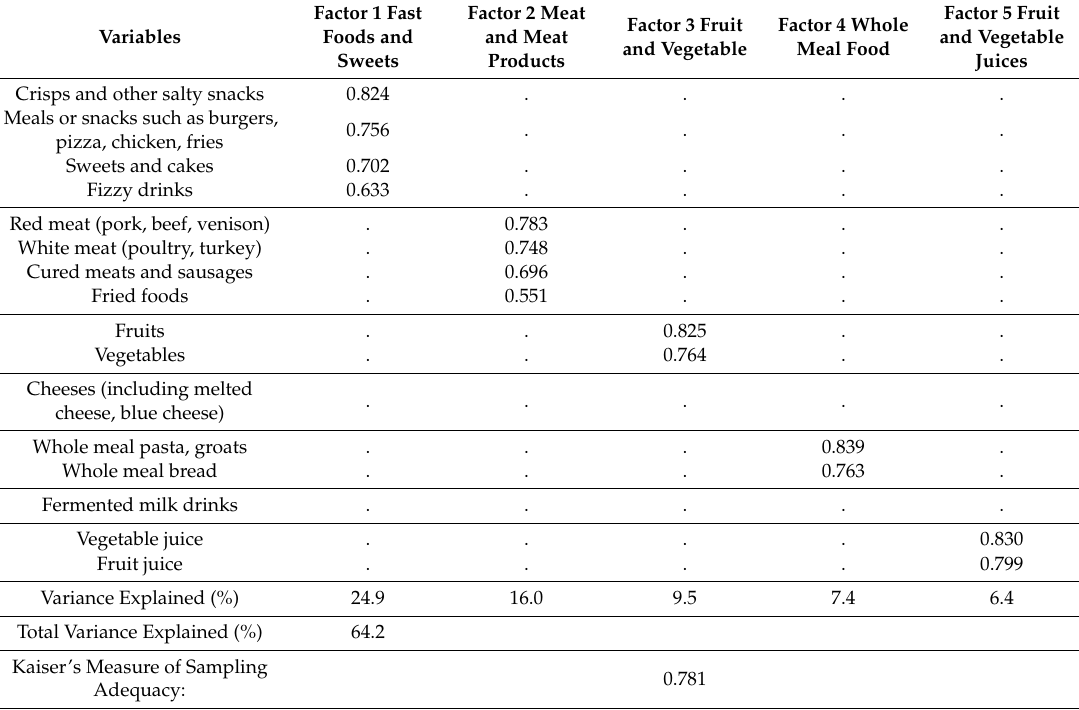
Table 2. Factor-loading matrix for the dietary patterns identified by principal component analysis (PCA).